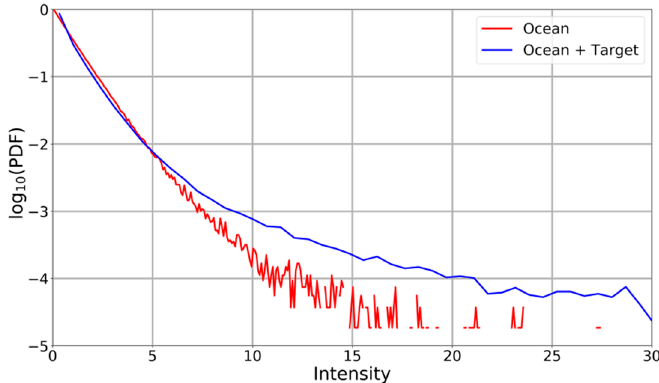
Figure 6. Logarithmic plot of the PDFs of the ocean only (red) and ocean with a ship signal (blue) are shown. For visualization purposes, the intensity axis is truncated as the maximum intensity due to the ship is around 600.